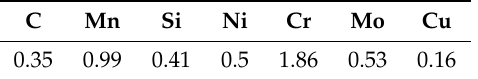
Table 1. Chemical composition of the studied steel (wt.